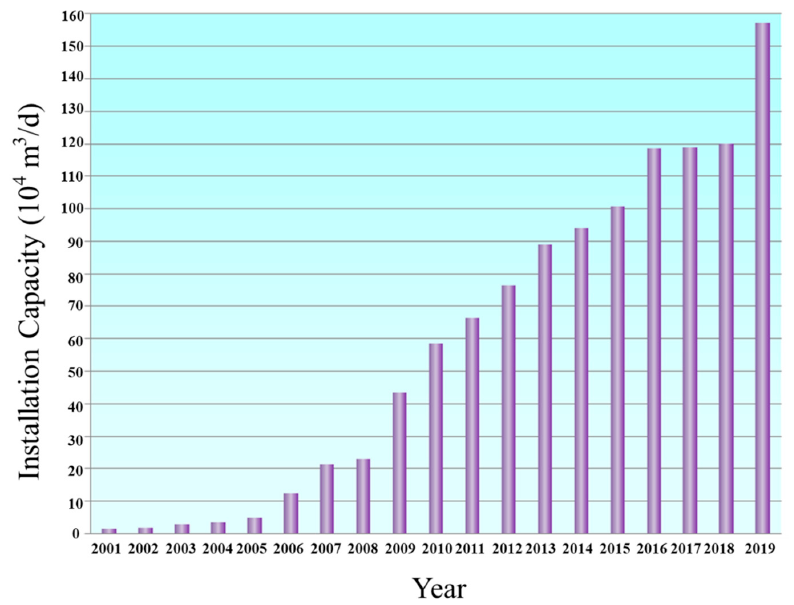
Figure 2. Diagram for the evolution of national seawater desalination capacity over the past two decades in China [8].